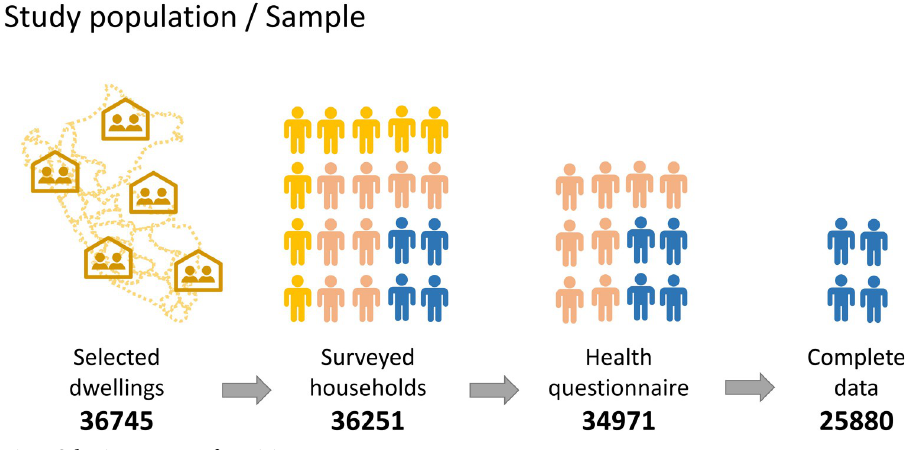
Fig 1. Selection process of